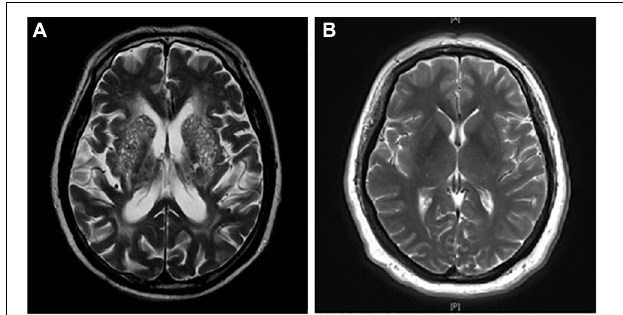
FIGURE 1 | Enlarged perivascular spaces in basal ganglia (BG-EPVS) group and control group. (A) Patients with EPVS > 20 on the unilateral side of the basal ganglia slice containing the maximum number were defined as the BG-EPVS group. (B) Patients with EPVS ≤ 20 on the unilateral side of the basal ganglia slice containing the maximum number were defined as the control